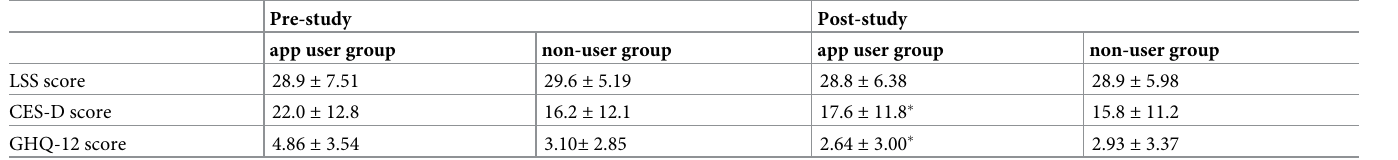
Table 3. Results of the psychological